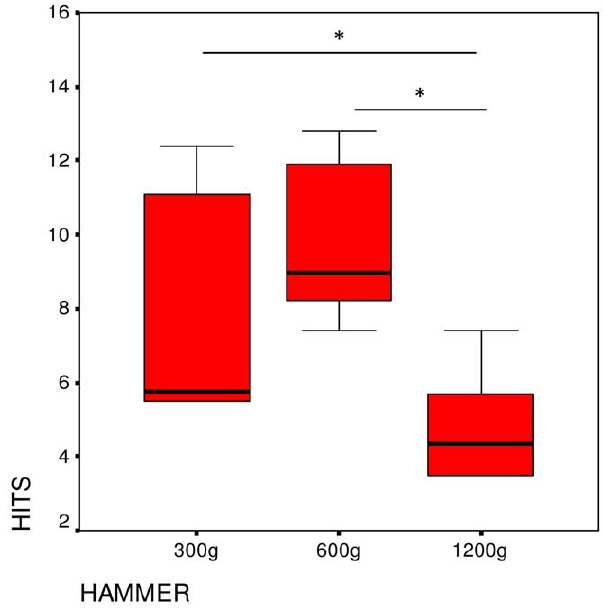
Figure 2. Median number of strikes needed to crack open a nut in Experiment 1. Also shown are the IQR and significance tests.